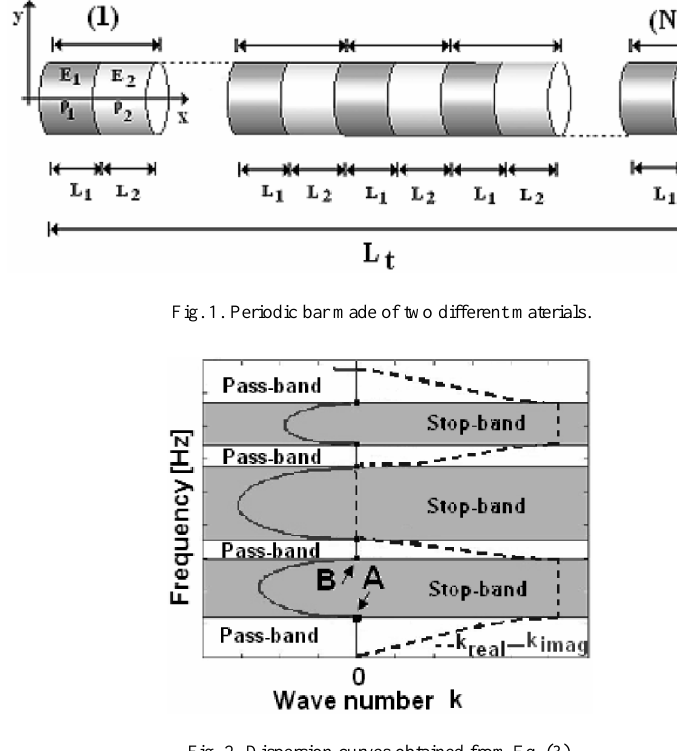
Fig. 2. Dispersion curves obtained from Eq.